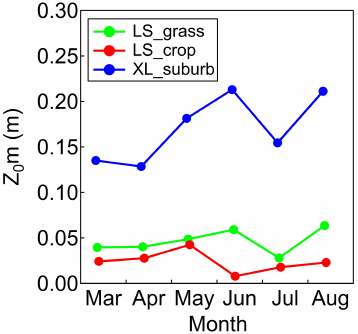
Figure 13. Monthly variations in surface roughness length at the three sites in Nanjing from March to August 2013.